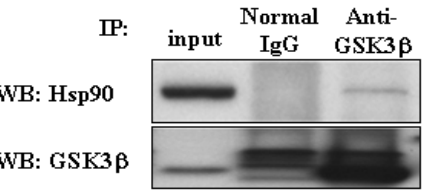
Figure 5. GSK3 b exist in a complex with Hsp90. GSK3 b was immunoprecipitated from COS cell lysate, the immunoreactive materials were subjected to SDS-PAGE and analyzed by immunoblot using anti-Hsp90 antibody and anti-GSK3 b